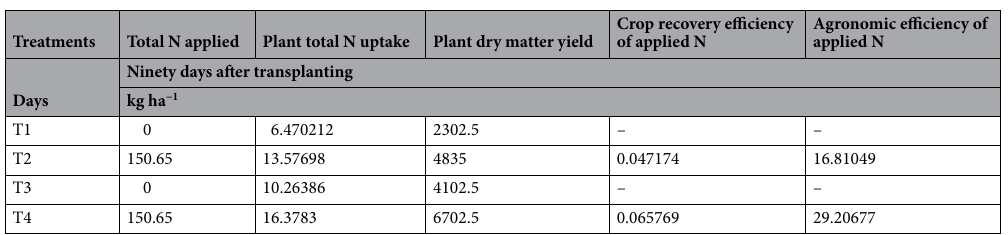
Table 22. Chicken litter biochar application and split application of urea on crop recovery and agronomic efficiency on day ninety after transplanting.